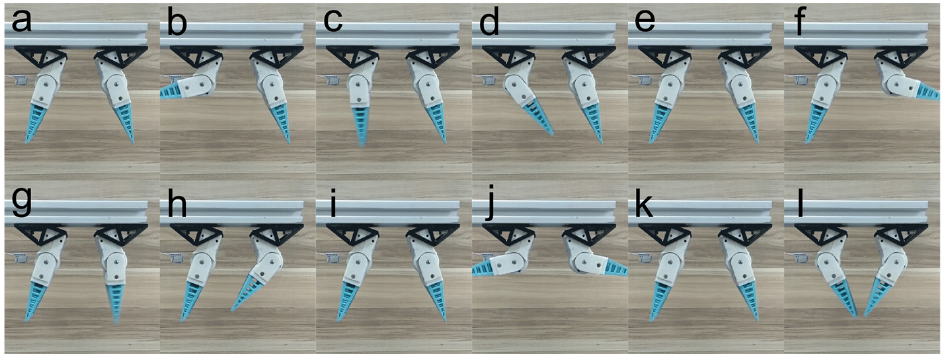
Figure 5. Independent motion control of the modular hand based on the control bus. ( a – d ) Control of the left hand individually, ( e – h ) Control of the right hand individually, ( i – l ) Control of the left and right hands simultaneously.